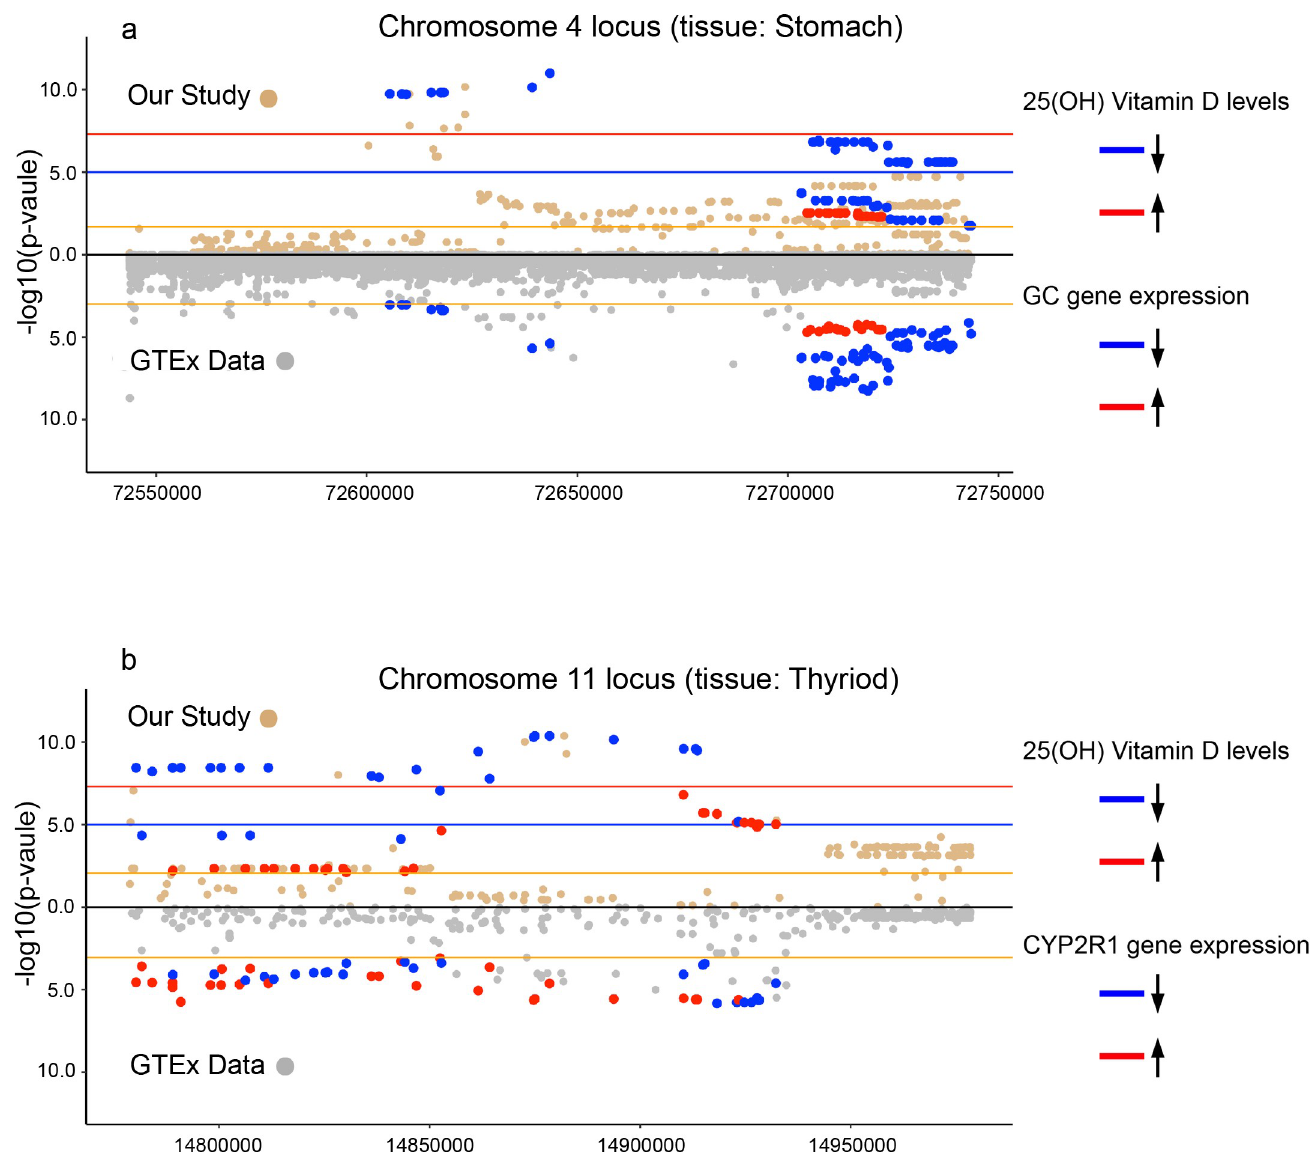
Fig 5. Association statistics for 25(OH)D in 24-month old children vs GTEx expression data. a) Association statistics for 25(OH)D in 24-month old children within the 200kb target window on chromosome 4 compared to the GTEx eQTL dataset for the tissue ‘Stomach’. All SNPs that both show a significant association statistic and are present in both datasets are colored either blue (-) or red (+), depending on the direction of the SNP’s beta coefficient. As shown in the figure, all significant SNPs present in both datasets have a concordant direction of association. b) Association statistic comparison for SNPs within the target window on chromosome 11, both in our study and in the GTEx dataset for the tissue ‘Thyroid’. Also for the chromosome 11 locus complete concordance in the SNP’s association direction is seen. (red line: genome-wide significance; blue line: genome-wide suggestive significance; orange line: FDR 0.05).